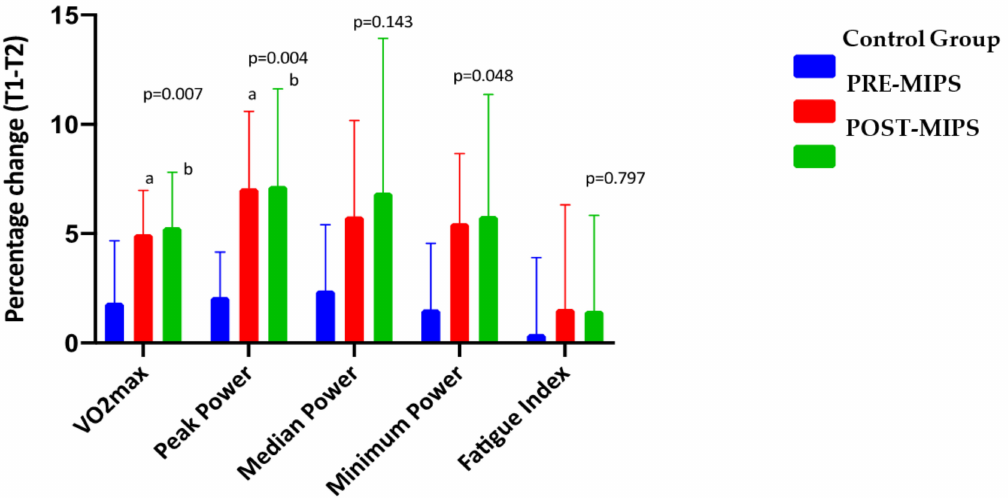
Figure 3. Percentage change in sport performance. The data are expressed as a mean ± standard deviation. ∆ (T1-T2) (%) = ((T2T1)/T1) × 100. T1: Before the start of the race; T2: After 10 weeks of treatment. p : p -value between groups. Significant values ( p < 0.005). a : Significant differences from the Control group ( p < 0.05). b : Significant differences from the PRE-MIPS ( p <